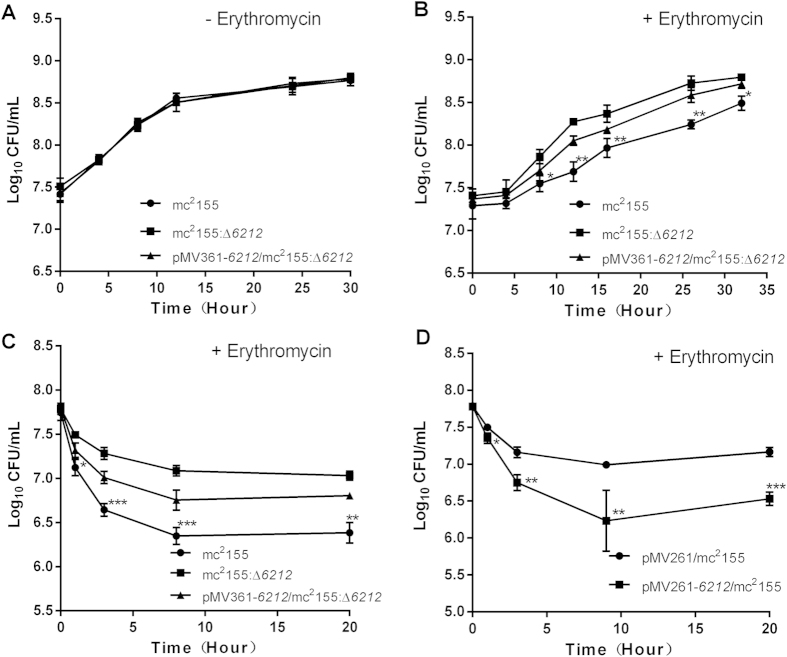
MSMEG_6212 is associated with erythromycin susceptibility.(A) Growth curve of mc2155, mc2155:Δ6212 and the complemented strain pMV361-6212/mc2155:Δ6212 in 7H9 medium. (B) Growth curve of mc2155, mc2155:Δ6212 and the complemented strain pMV361-6212/mc2155:Δ6212 in 7H9 medium with 1.56 mg/L erythromycin (*p < 0.05, **p < 0.01). (C) Killing curve for mc2155, mc2155:Δ6212 and the complemented strain pMV361-6212/mc2155:Δ6212 in 7H9 medium with 31.25 mg/L erythromycin (*p < 0.05, **p < 0.01, ***p < 0.001). (D) Killing curve for pMV261/mc2155 and pMV261-6212/mc2155 in 7H9 medium with 15.6 mg/L erythromycin (*p < 0.05, **p < 0.01, ***p < 0.001).